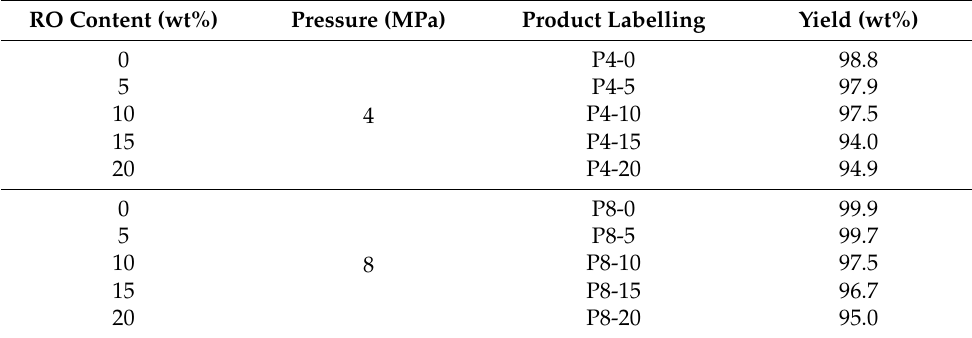
Table 1. RO content in the feedstock, the reaction pressure, the labelling of the obtained products, and the liquid product